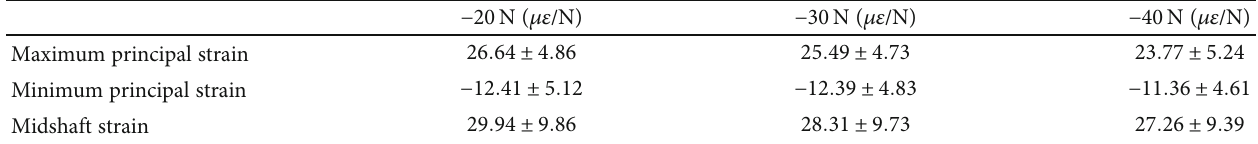
Figure 9: Typical strain-load curves under di ff erent peak axial compressive loads: (a) − 20N peak load; (b) − 30N peak load; (c) − 40N peak load. Table 2: The slopes of the strain-load curves obtained by strain gauge measurement ( mean ± SD